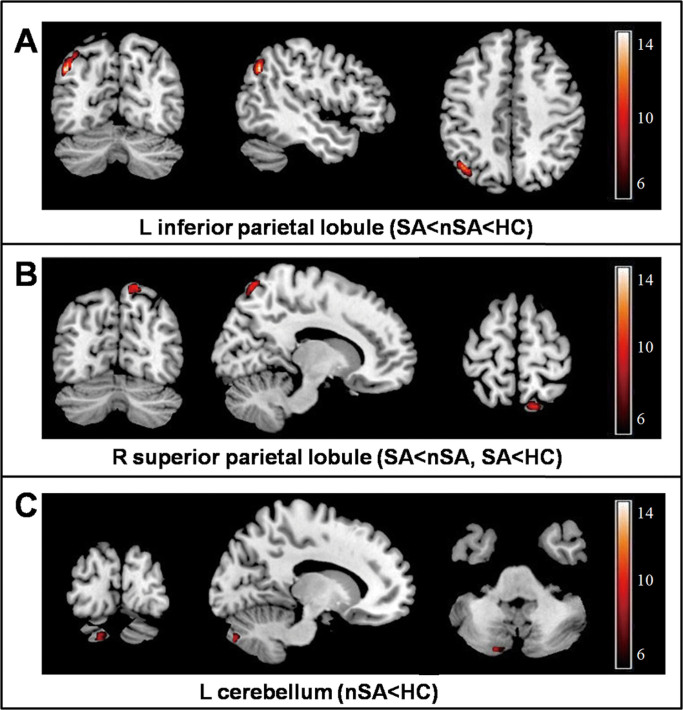
Magnetization transfer ratio differences in voxel-based analysis comparisons among major depressive disorder patients, with and without a history of suicide attempts, and healthy comparison subjectsa.a Images are presented in neurological convention. Suicide attempters showed reduced MTR in (A) the left inferior parietal lobule and (B) the right superior parietal lobule relative to non-attempters and healthy controls. Non-attempters showed reduced MTR in (A) the left inferior parietal lobule and (C) the left cerebellum (posterior lobe) relative to healthy controls. Statistical inferences were made with a voxel-level statistical threshold of p < 0.05 (corrected). Abbreviations: HC = healthy comparison subjects; L = left; MTR = magnetization transfer ratio; nSA = depressed patients without a history of suicide attempts; R = right; SA = depressed patients with a history of suicide attempts.